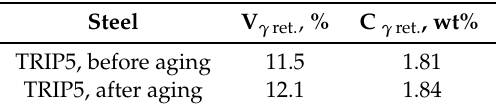
Table 2. XRD results before and after aging. The paint-baking simulations were at 170 ◦ C for 20 min for the TRIP5 steel. Steel V γ ret. , % C γ ret. , wt% TRIP5, before aging 1.81 12.1 1.84